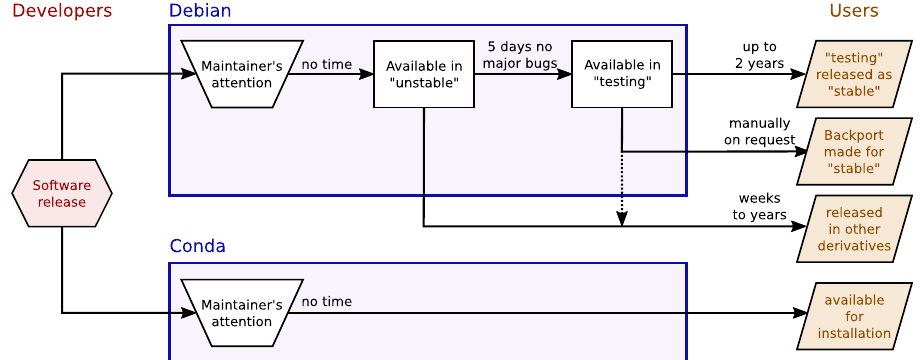
Fig. 2 The software distribution process for packages in a Linux distribution such as Debian (upper) and in a smaller immediate- availability catalogue such as Conda/Bioconda (lower). The Conda system renders packages immediately available across many releases of many Linux distributions and the macOS. The arrival in Debian’s